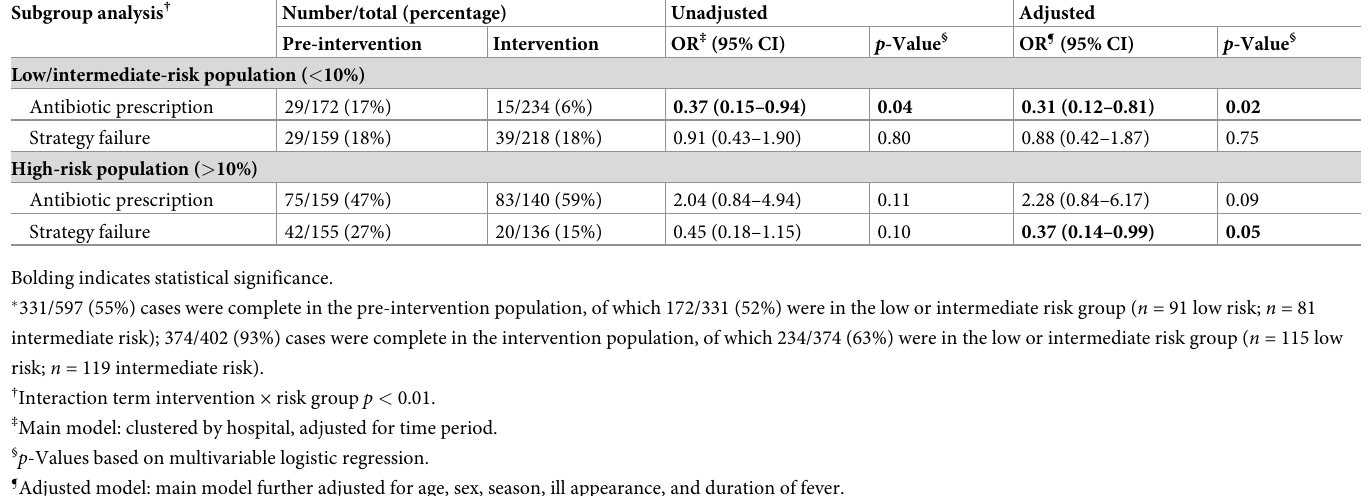
Table 3. Exploratory subgroup analysis on complete cases ( n = 705) � .